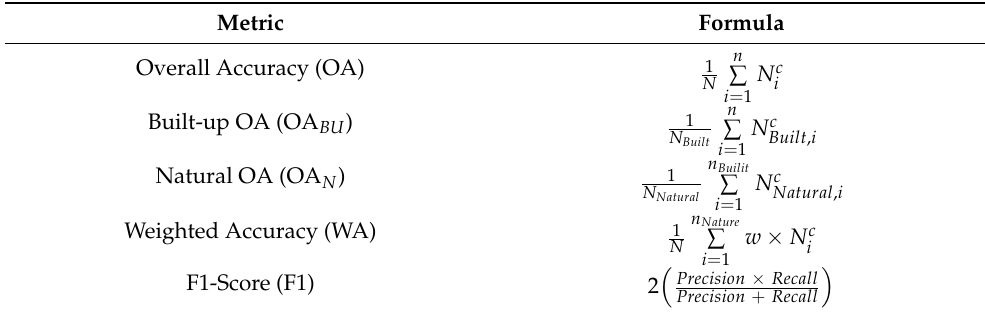
Table 6. Description of accuracy metrics. N c weight matrix introduced by Betchel